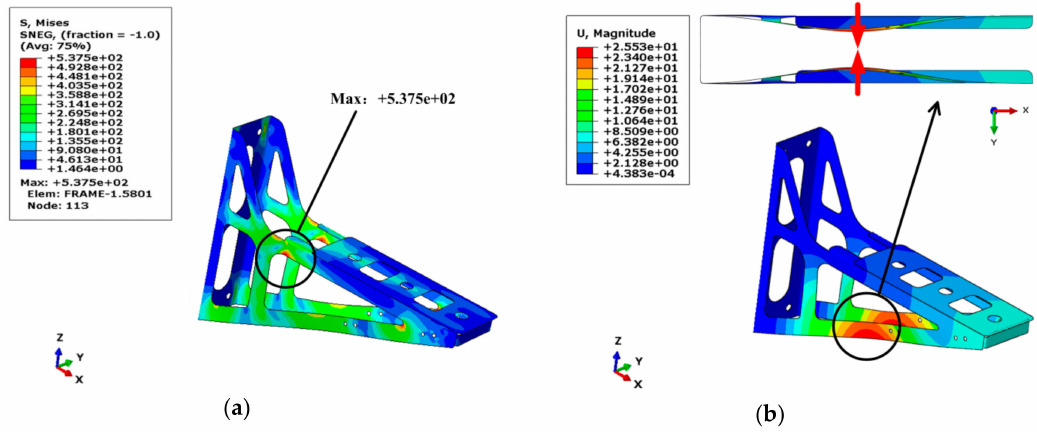
Figure4. VonMisesstressnephogram( a )and( b